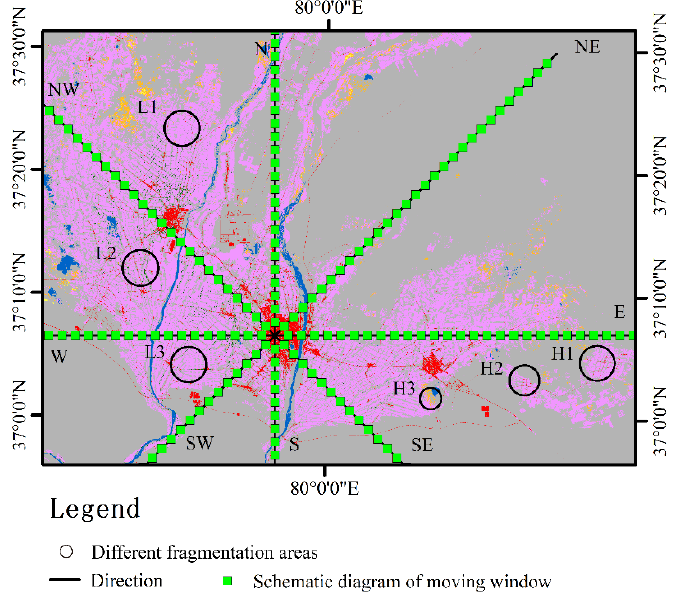
Figure 2. Schematic diagram of gradient analysis and selection of plots with different fragments.